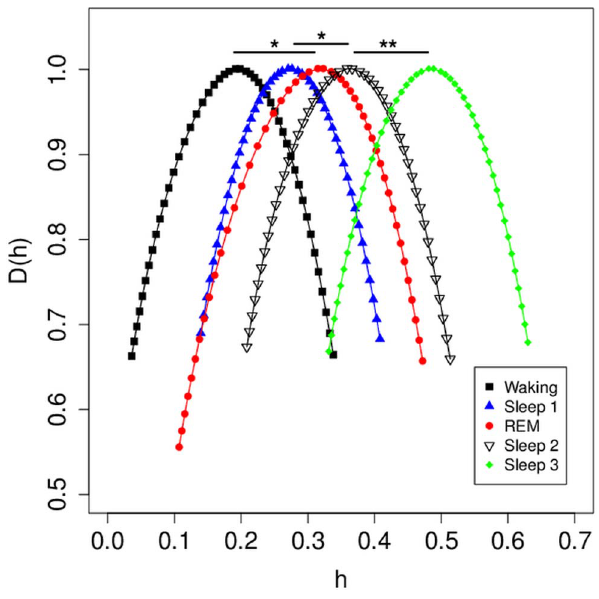
Figure 5. Comparison among stages of sleep for 1 minute of EEG data. For each stage from each subject, 1 min of EEG data was used to calculate MF-DFA spectra. Average MF-DFA spectra for each consciousness state shown here were calculated by averaging across individual spectrum values for each subject. Mean h values were then calculated for the h range, and differences between sleep stages compared by paired t testing. * p , 0.05; ** p , 0.01. Significant differences were found for the waking-REM, Sleep 1-Sleep 2, and Sleep 2-Sleep 3 comparisons.